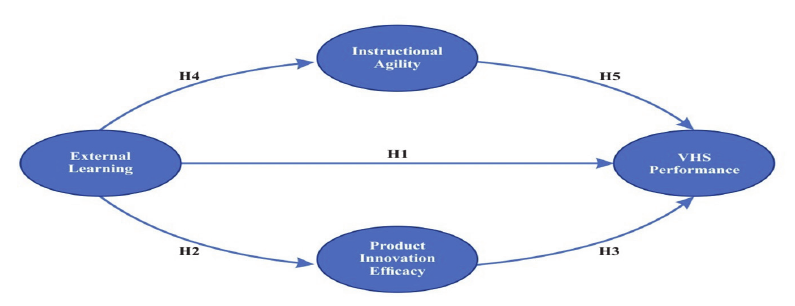
Fig. 1. Conceptual Model of the